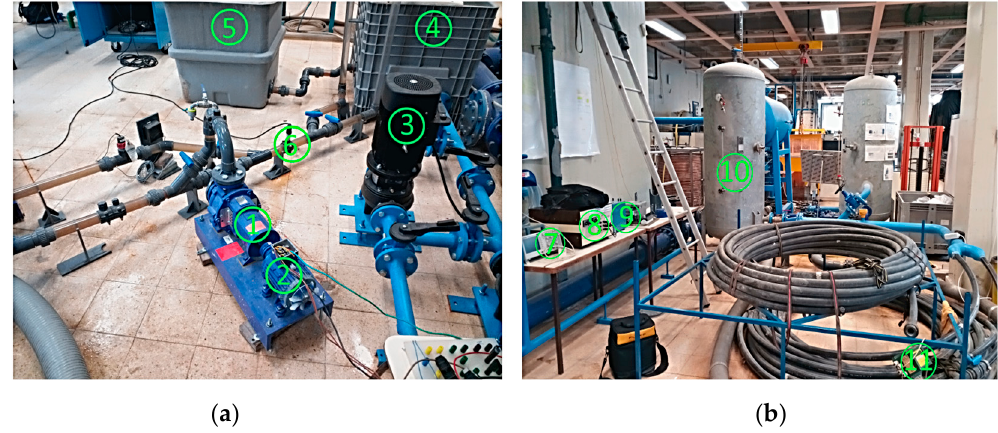
Figure 14. Experimental hydraulic circuit developed for validation of the PAT model: in ( a ) the PAT-SEIG, control flow tanks and recirculating pump and, in ( b ) the pressure tank and the resistive load and capacitors.